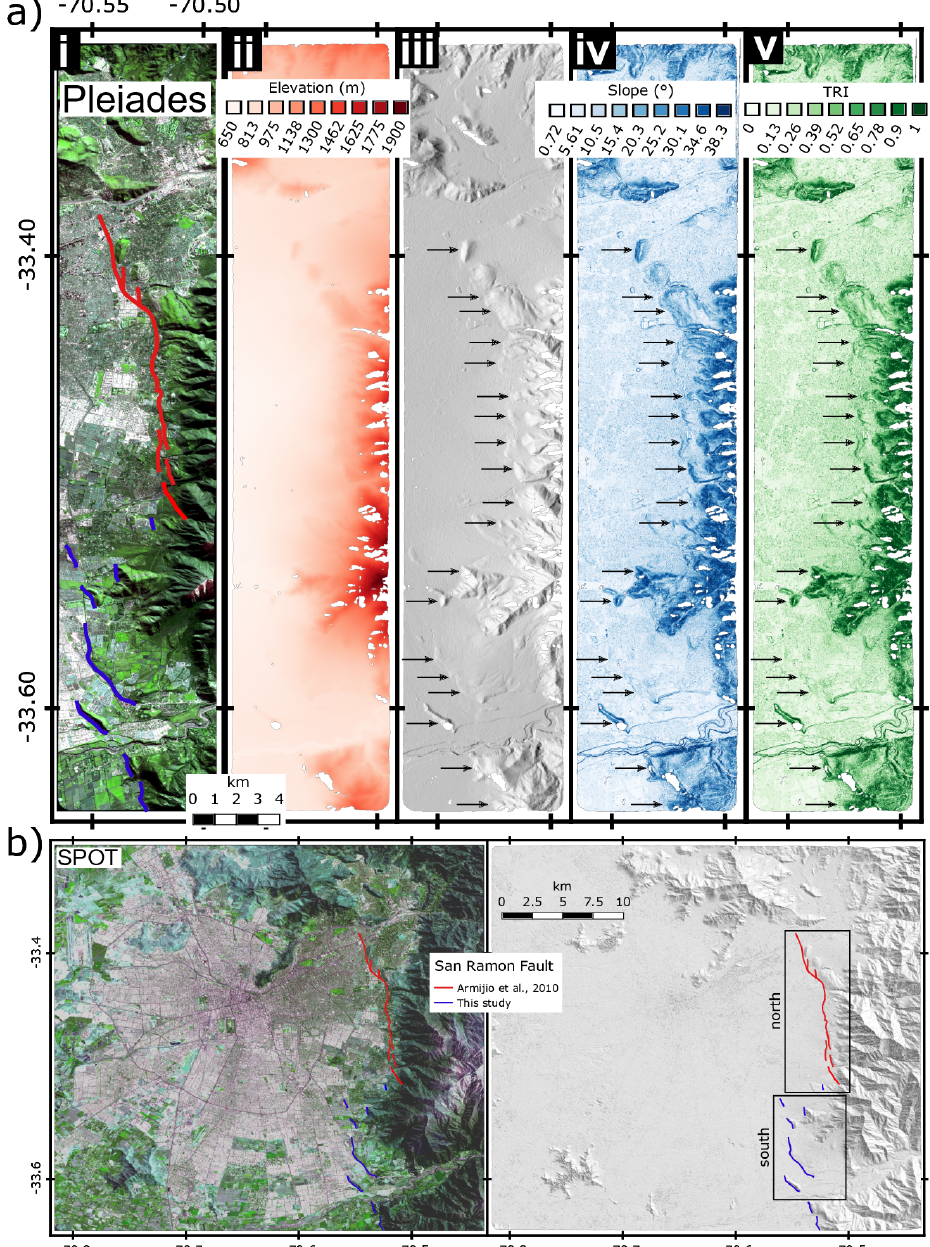
Figure 3. (a) (i) The Pléiades satellite optical multispectral image, (ii) the elevation map created using photogrammetry analysis of the panchromatic optical image, (iii) the hillshaded digital elevation model (DEM), (iv) slope map, and (v) – the terrain ruggedness index (TRI). Data gaps are on steep slopes in shadow, resulting in low contrast and inability to derive heights from stereo image matching. (b) The SPOT satellite multispectral image (left) and the resulting hillshaded DEM (right) derived from stereo panchromatic pairs. (Pléiades © CNES, 2016; distribution by Airbus DS/Spot